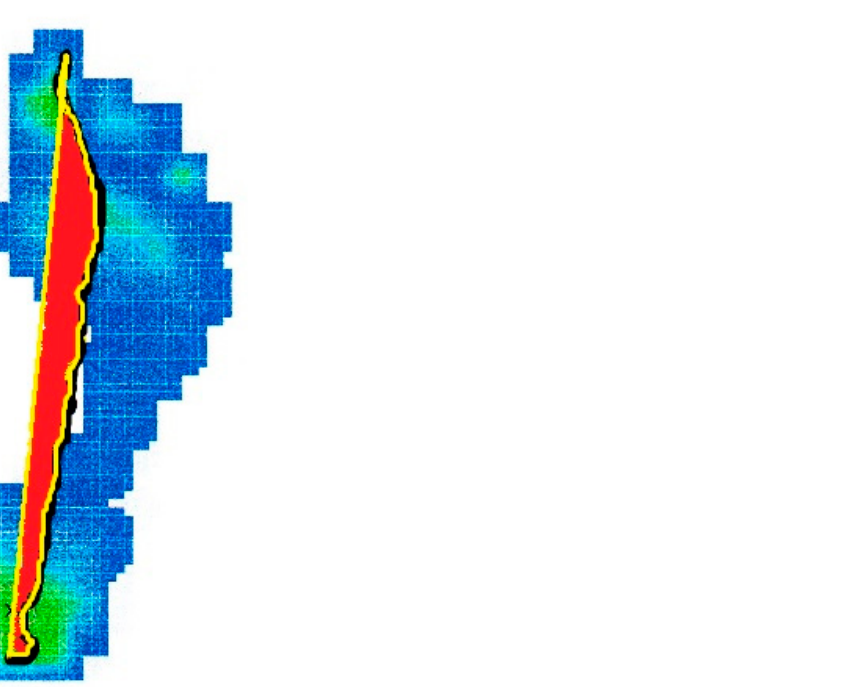
Figure 4. Low-Dye tape.